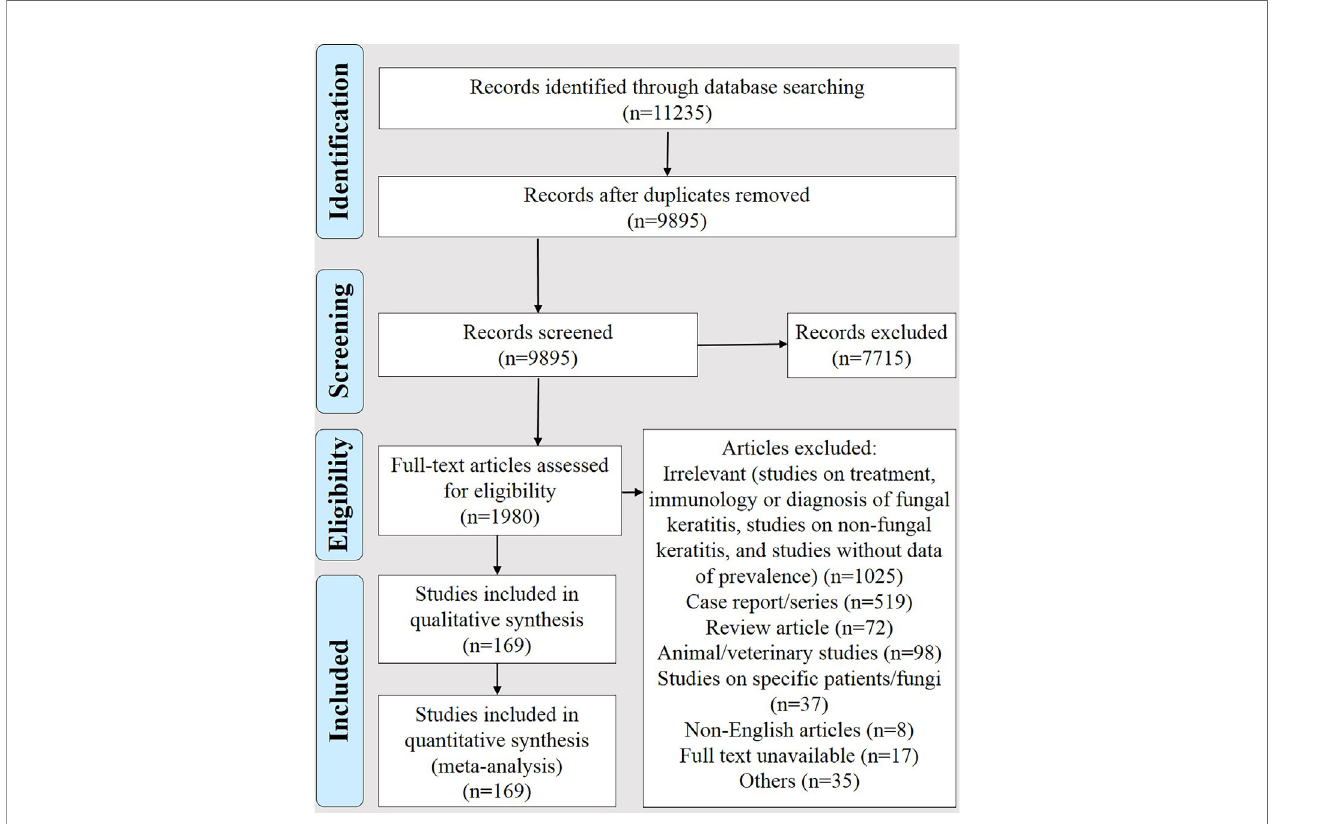
FIGURE 1 | The PRISMA fl ow diagram of selecting studies reporting data on the prevalence of fungal keratitis between January 1, 1990 and May 27, 2020.